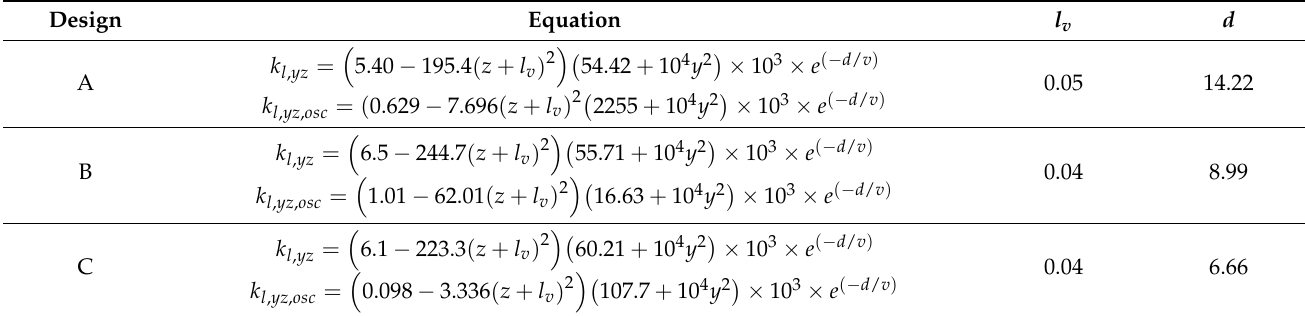
Table 6. Mathematical expressions of the levitation stiffness.